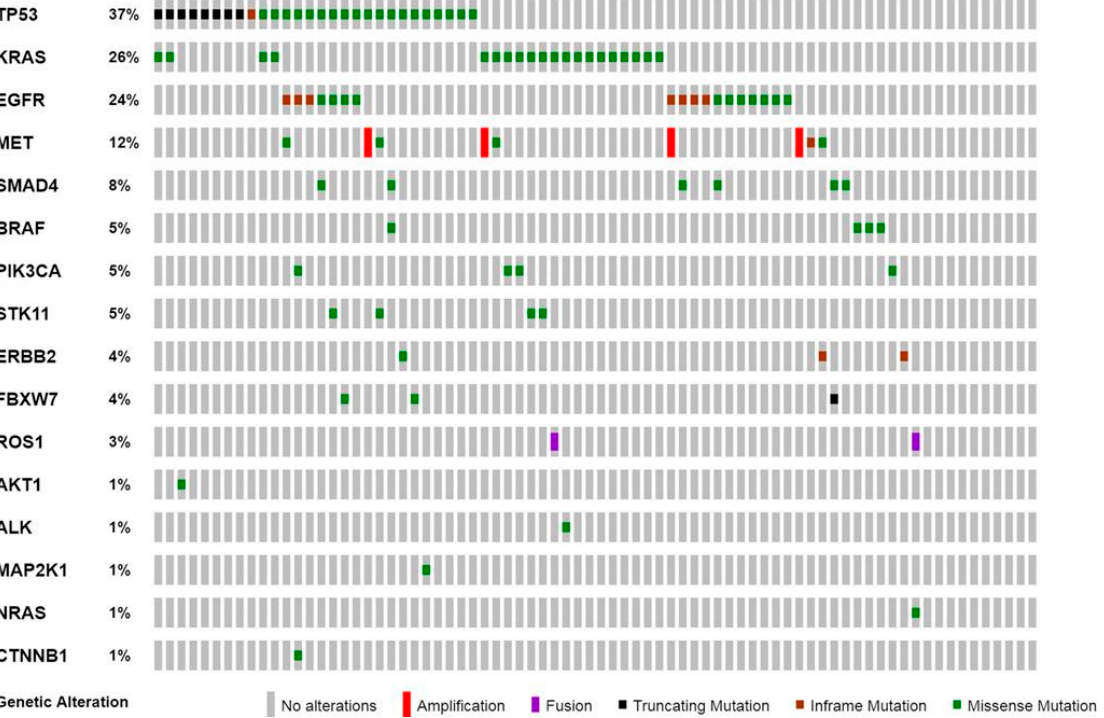
Figure 1. Oncoprint plot showing the distribution of genomic alterations identified in the study cohort. The co-occurrence of EGFR exon 19 deletion and T790M missense mutation was reported as a missense mutation. Genes without genomic alterations were not reported. Table 2. Frequencies of genomic alterations and PD-L1 expression detected in NSCLCs from the octogenarian patients of the study.